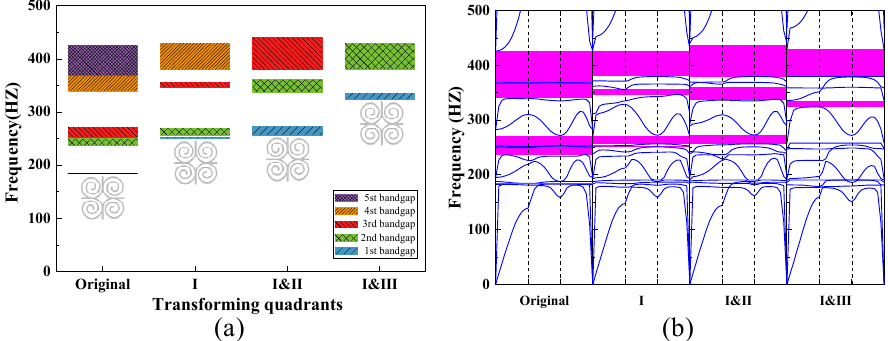
Figure 15. The dependence of the bandgap width on the spiral ( a , b ) transforming quadrants, where the number “original” represents the bandgap distribution for the parameter shown in Table 2, the number “I” represents a transformation of the spiral arrangement in the first quadrant, the numbers “I&II” represents a transformation of the spiral arrangement in the first and second quadrants, and the numbers “I&III” represents a transformation of the spiral arrangement in the first and third quadrants.